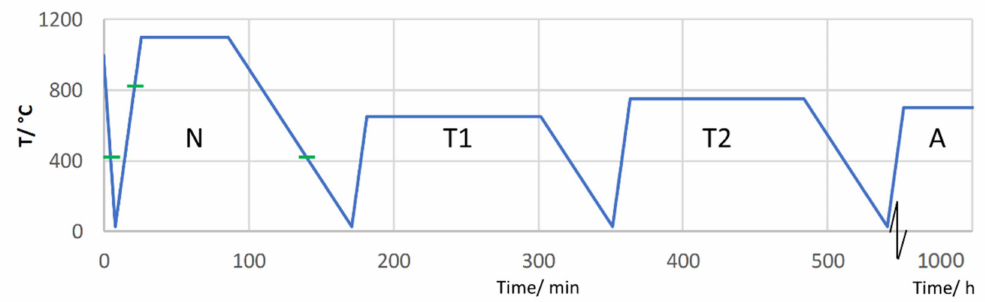
Figure 1. Thermal history of